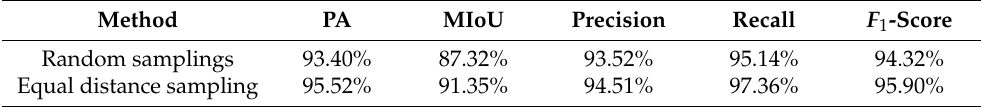
Table 7. Accuracy assessment for mapping.